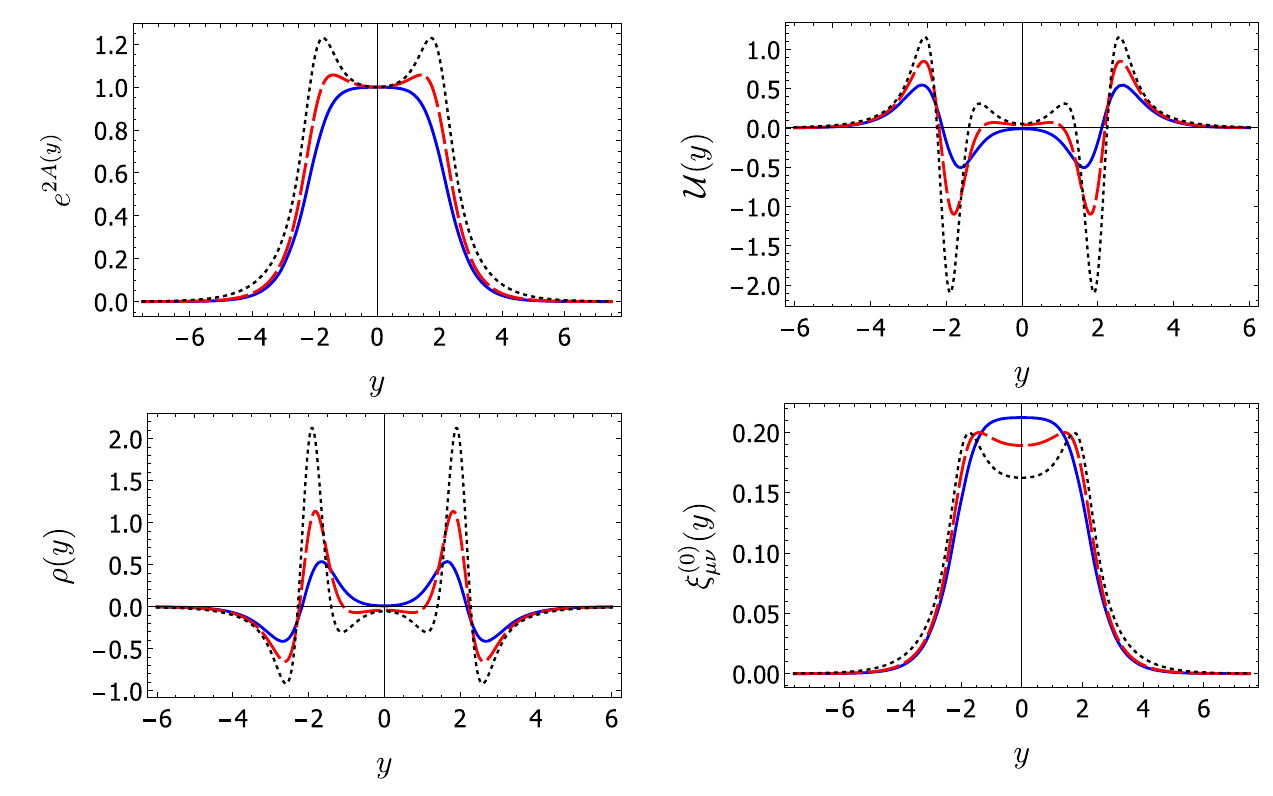
Fig. 1 Warp factor (top panel) and energy density (bottom panel) depicted for c = 2 and α = 0 (solid-line), α = 0 . 5 (dashed-line) and α = 1 (dotted-line)